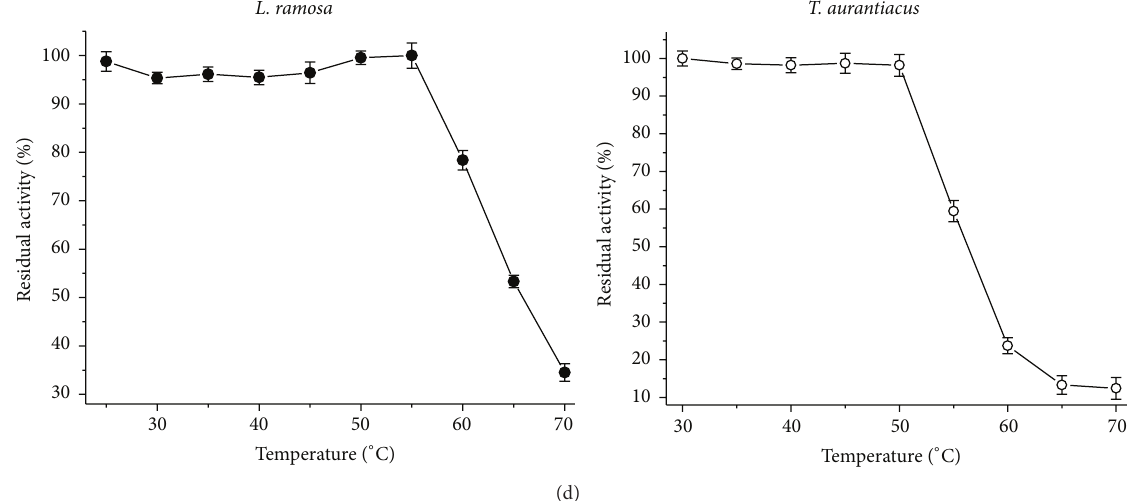
Figure 2: Effect of pH and temperature on amylase activity of L. ramosa and T. aurantiacus . (a) Amylase activity at different pHs and (b) at different temperatures; (c) amylase residual activity after 24 h at different pHs and (d) after one hour at different temperatures (each data point was the average of two replicate determinations, and the error bars show the data ranges).